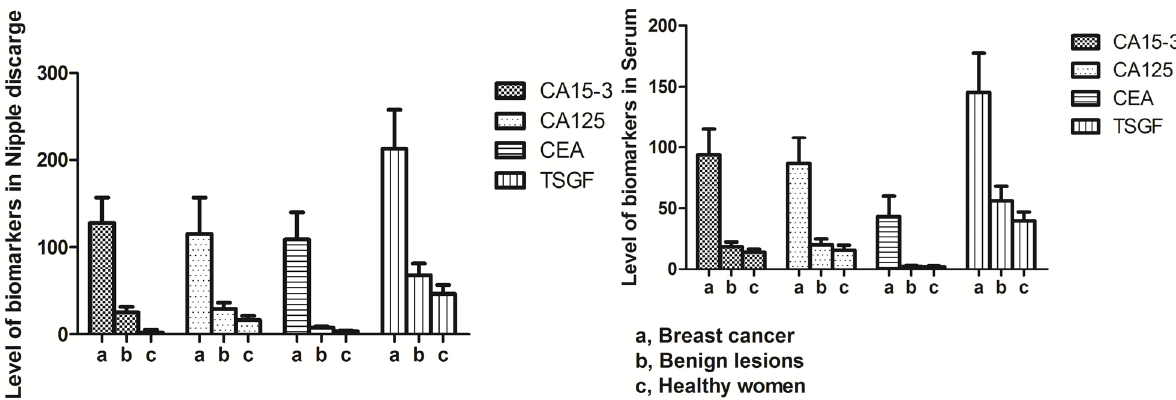
Figure 1. Nipple-discharge and serum biomarkers levels among the three